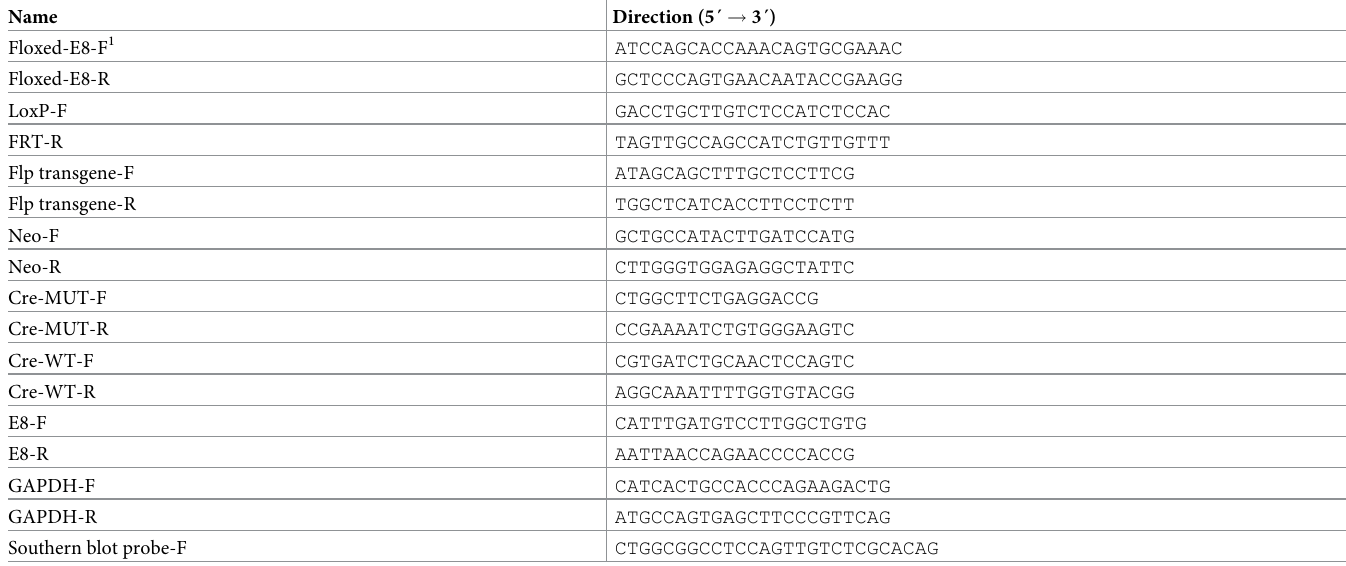
Table 1. PCR primers and southern blot